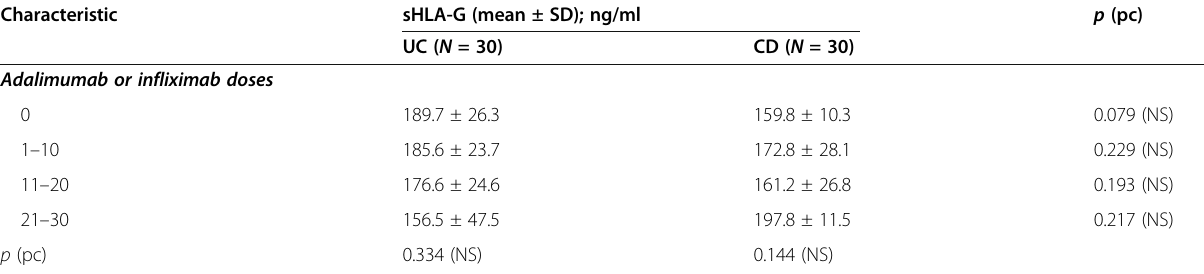
Table 3 Serum level of soluble HLA-G antigens in ulcerative colitis and Crohn ’ s disease distributed according to some characteristics of patients (Continued)